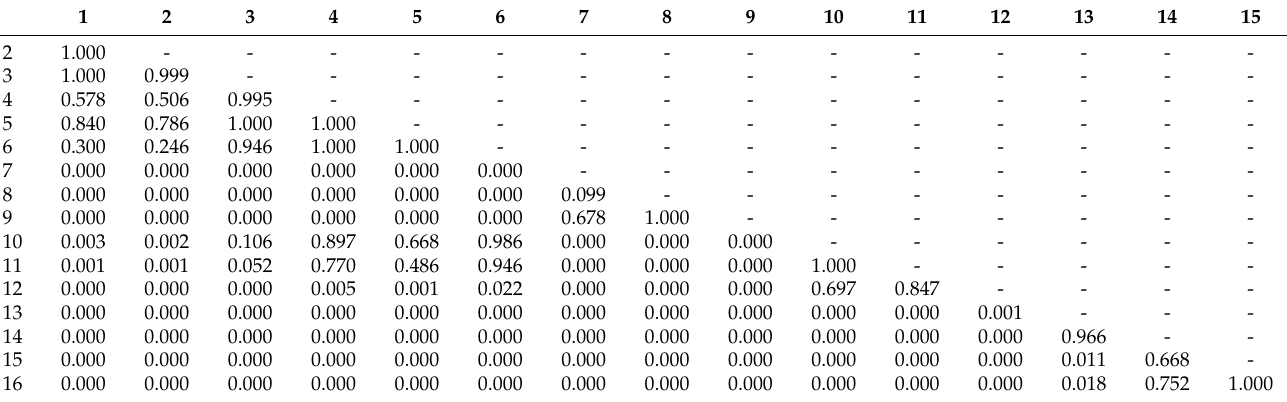
Table A6. p -values obtained from the Nemenyi test applied to the LPIPS results. Row/Column names are listed in Table